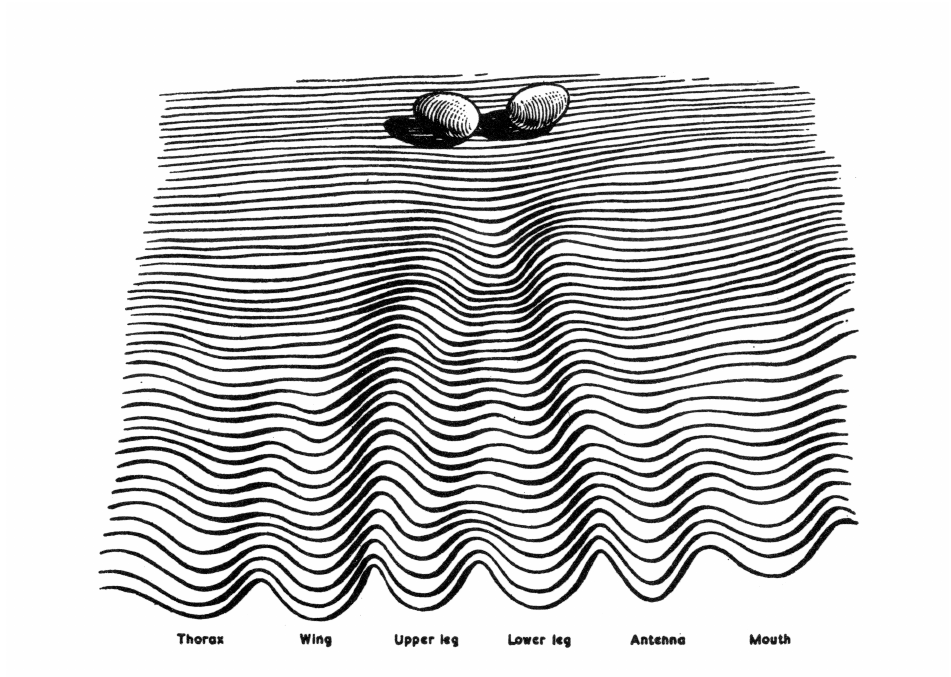
The ‘Epigenetic Landscape,’ from Conrad H. Waddington, Principles of Embryology (London: Allen and Unwin, 1956), 351 (photo: